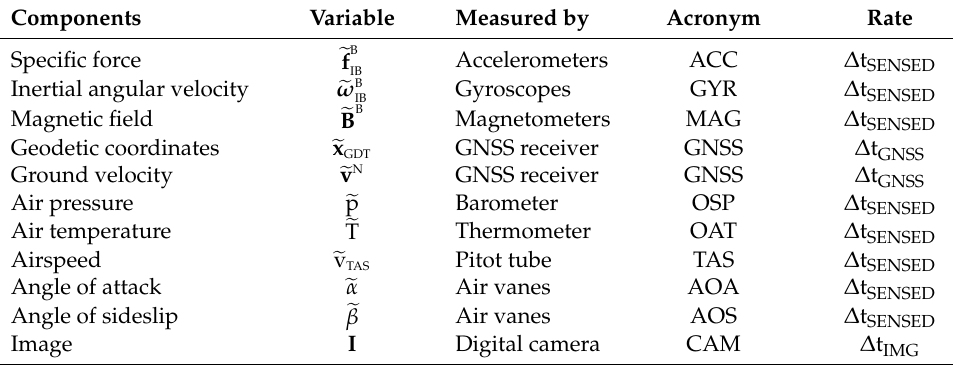
Table 1. Components of sensed